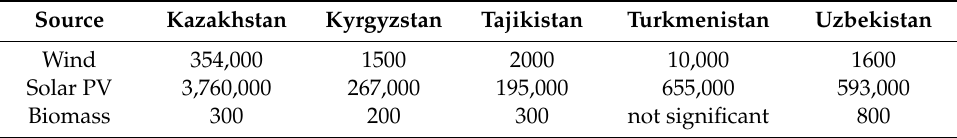
Table 8. Technical Potential for Installed Renewable Electricity Capacity in MW (Source: author, compiled based on UNDP Renewable Energy Snapshot for respective Central Asian